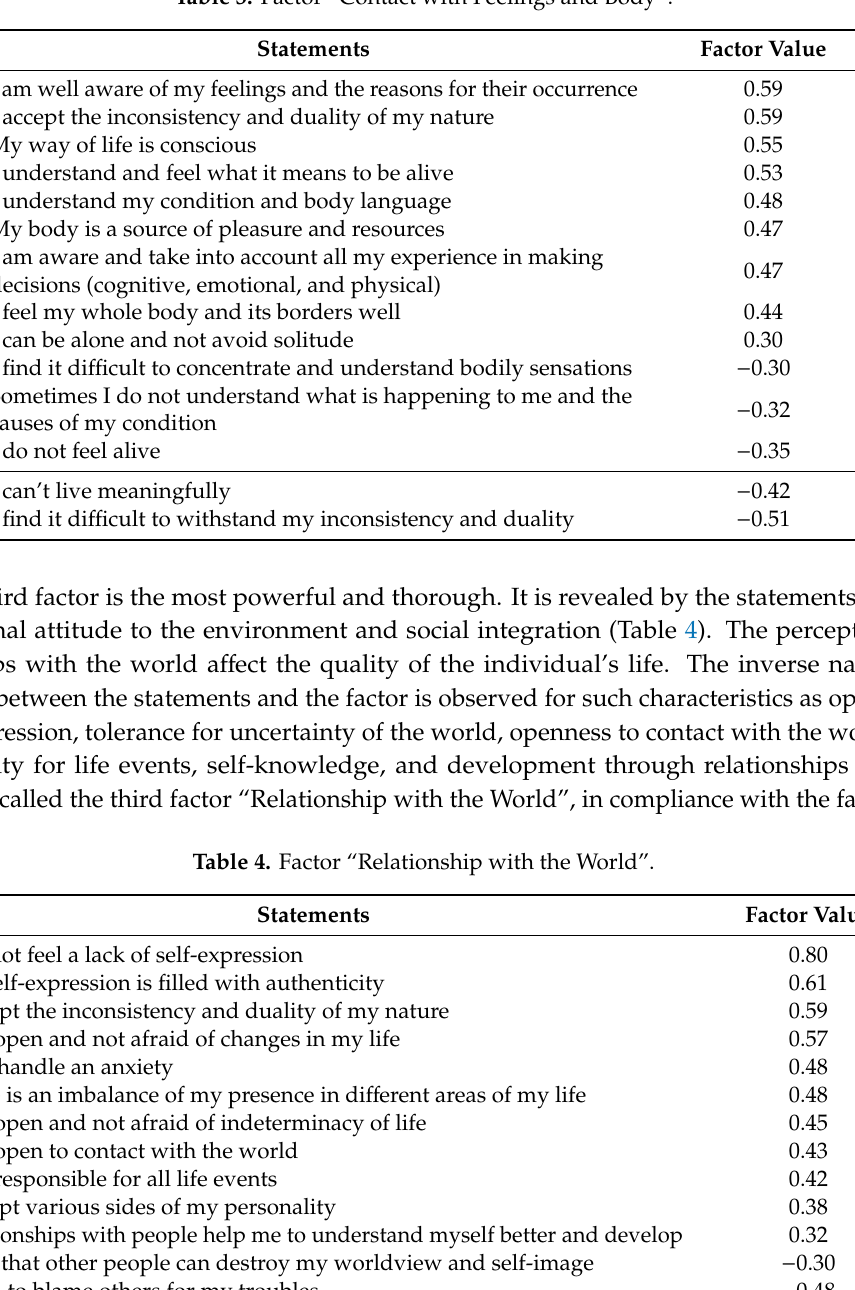
Table 3. Factor “Contact with Feelings and Body”.